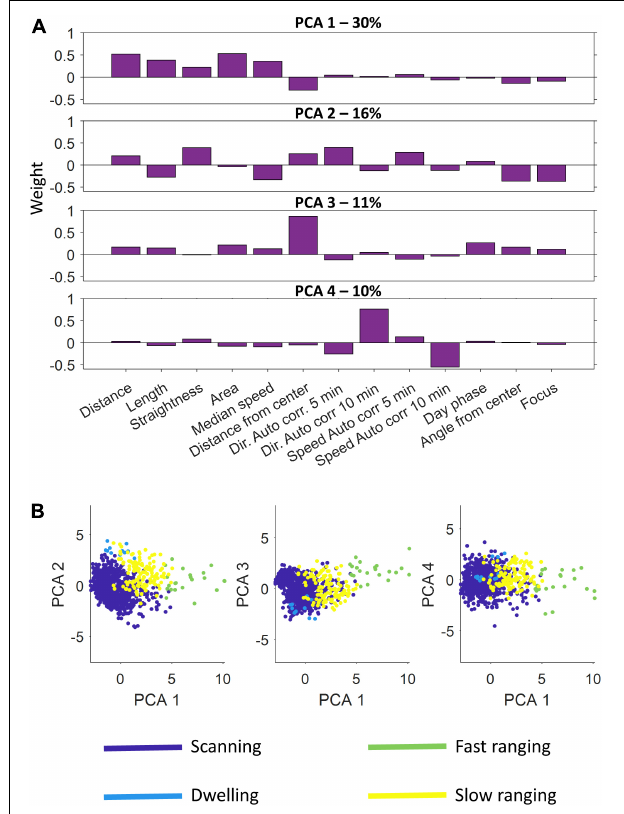
FIGURE 5 | Principal component analysis and semi-automatic agglomerative clustering. (A) A principal component analysis was performed on the feature sets of the segments. Shown are the four principal components used. Each component emphasizes a different set of features. (B) After dimension reduction using principal component analysis, semi-automatic agglomerative clustering was performed to divide the segments into four classes: scanning, dwelling, fast ranging and slow